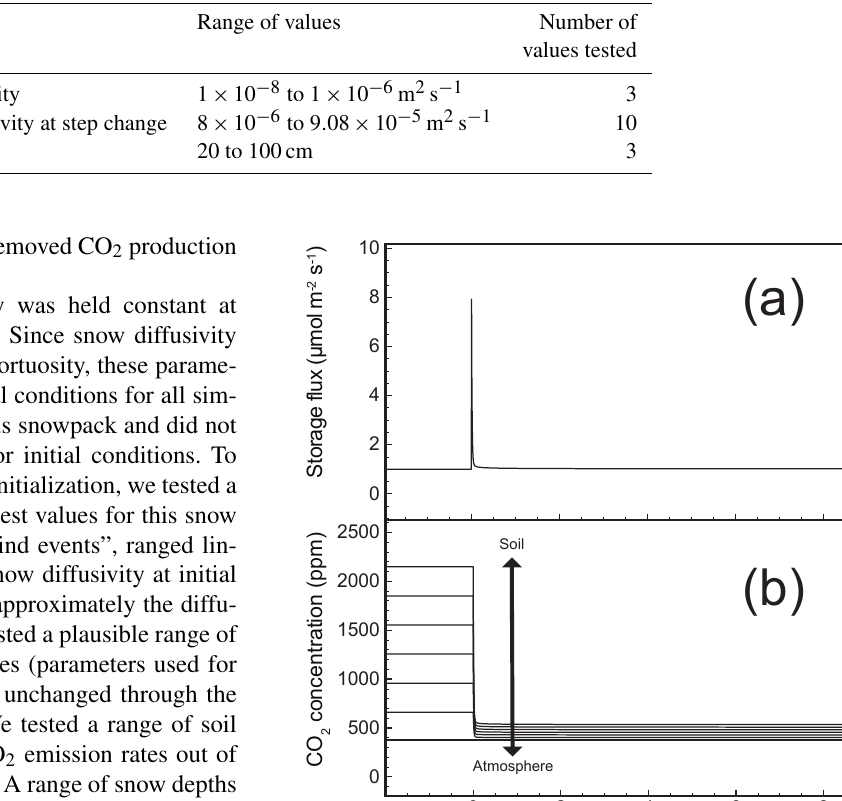
Table 1. A 1-D soil CO 2 diffusion model was adapted for the soil–snow system. The model simulated step changes in transport rate over a broad range of plausible synthetic cases. Soil diffusivity ranged logarithmically, whereas snow diffusivity and snow depth ranged linearly. We ran the model with all possible permutations of these parameters.